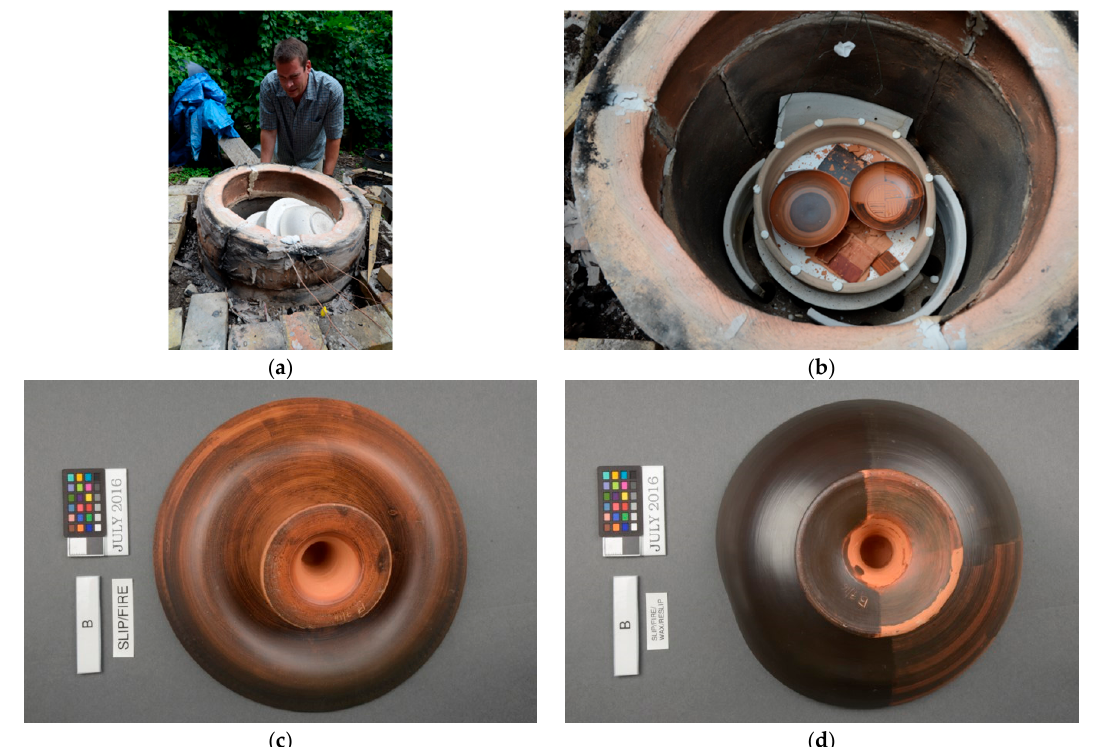
Figure 12. The leaned over kiln stack ( a ); the broken shelves inside the kiln ( b ); and the distorted pots ( c , d ).